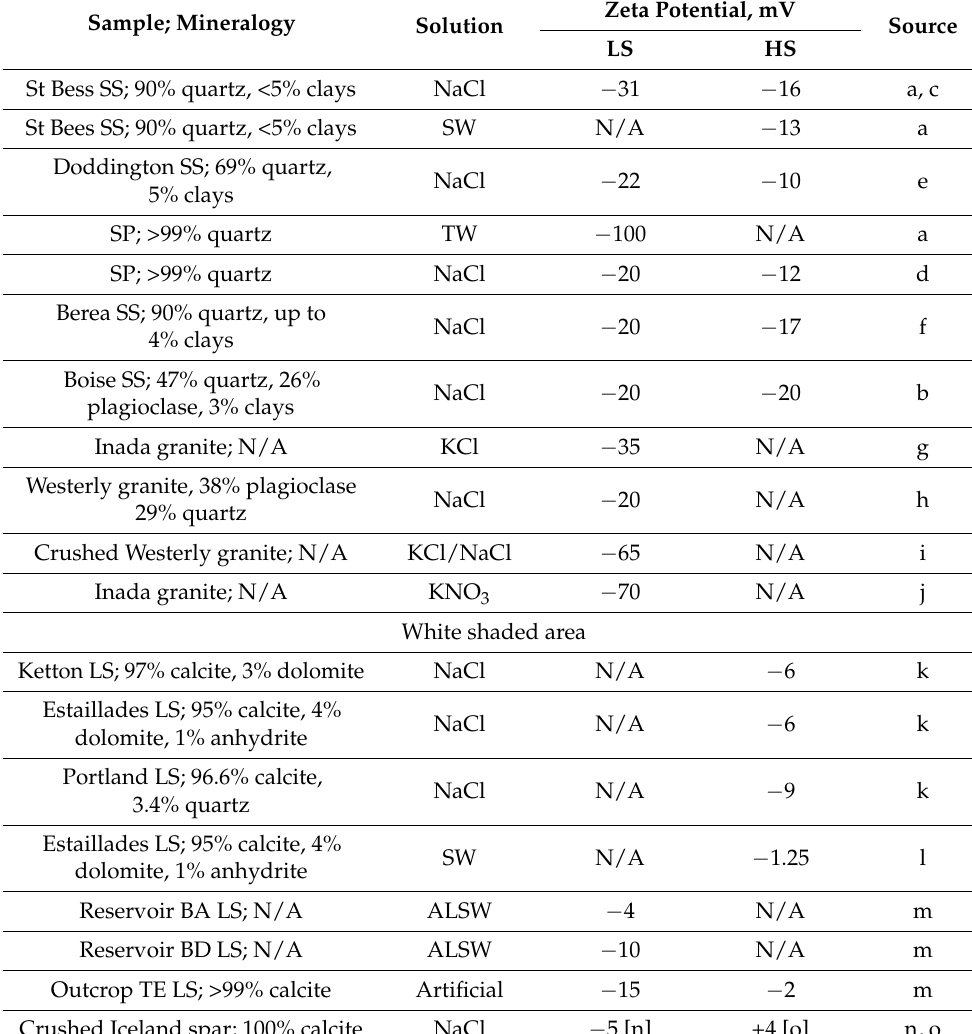
Table 2. Cont. Sample; Mineralogy